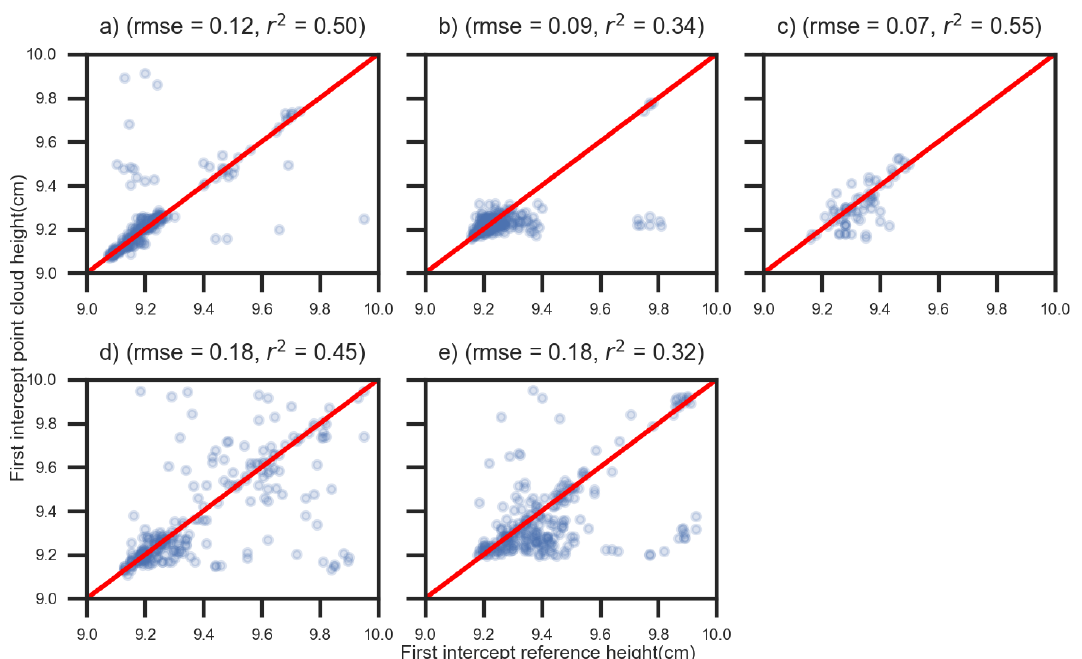
Figure 6. SfM estimate of first intercept height derived from point clouds in comparison to direct measurements at: ( a ) High Camp; ( b ) Ridgeway; ( c ) Royal park; ( d ) Silvan1; and ( e ) Silvan2. Both the x and y axes show height relative to the origin of the reference